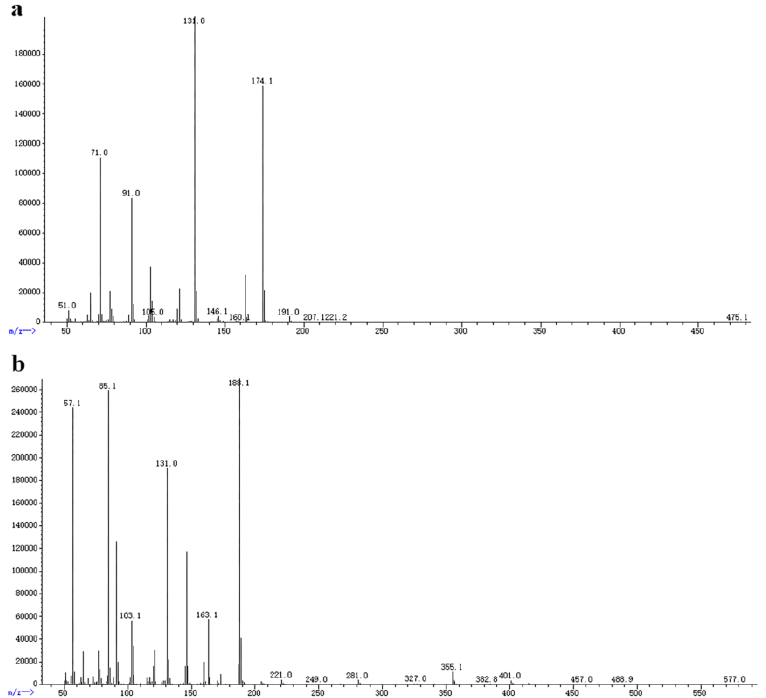
Figure 5. GC – MS results of volatile organic compounds produced by Xenorhabdus bovienii . CK is the blank control and SF1, SF2, and SF3 are three replicate samples in the experimental group.